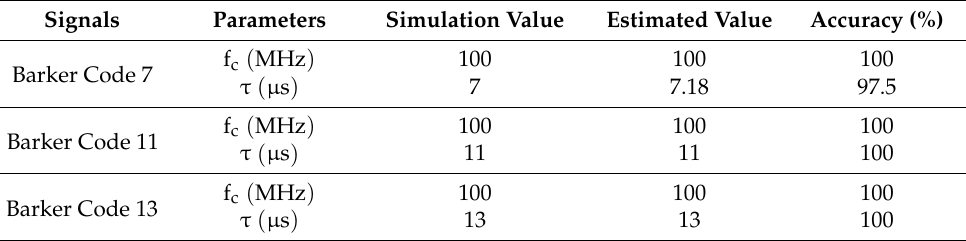
Table 4. Estimated parameters of the generated BPSK signals in the form of Barker Codes 7, 11, and 13.